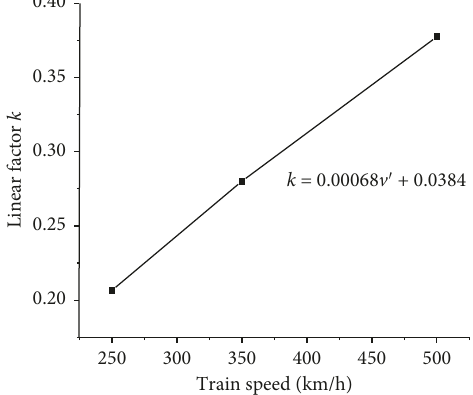
Figure 13: Linear factor at different train